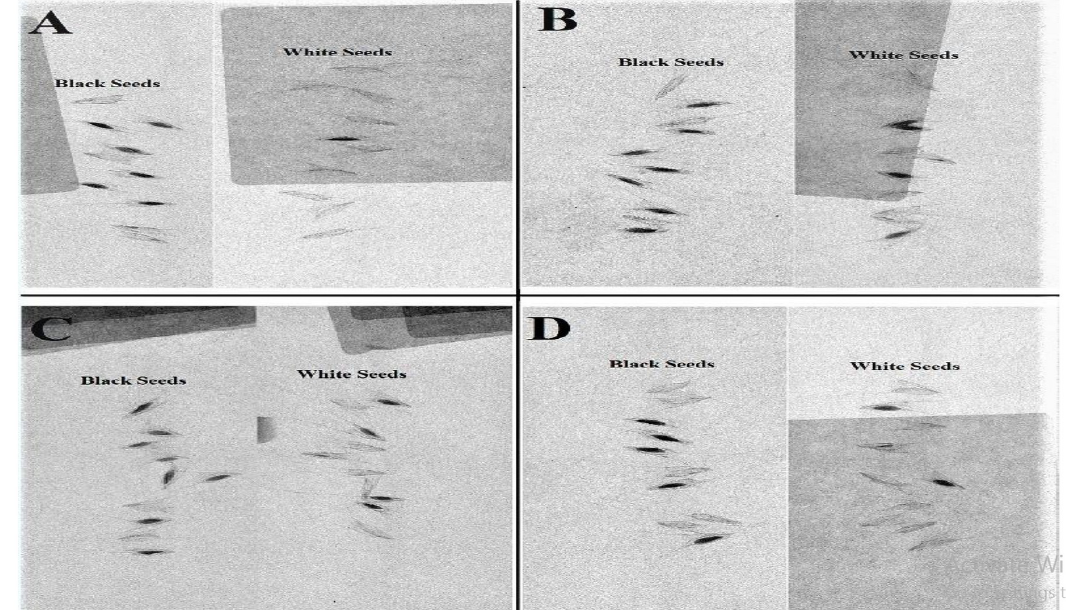
Fig 1. Reductions in germination percentage of two glyphosate-susceptible (Ch and SGM2) and glyphosate-resistant (SGW2 and CP2) populations of Chloris virgata at decreasing osmotic potential levels at different alternating temperature regimes. The estimated parameters were presented in Table